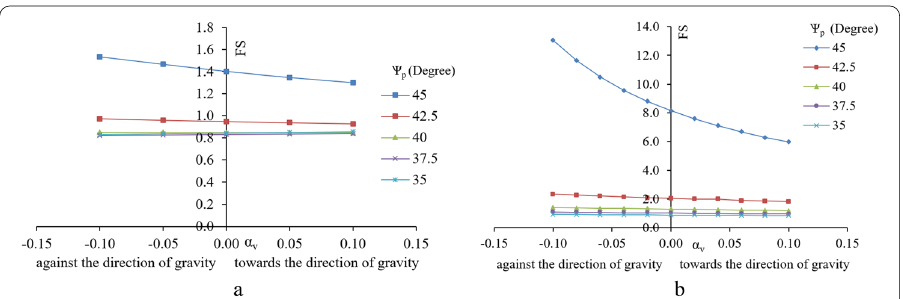
Fig. 5 FS vs α v on different values of Ѱ p : a case 1and b case